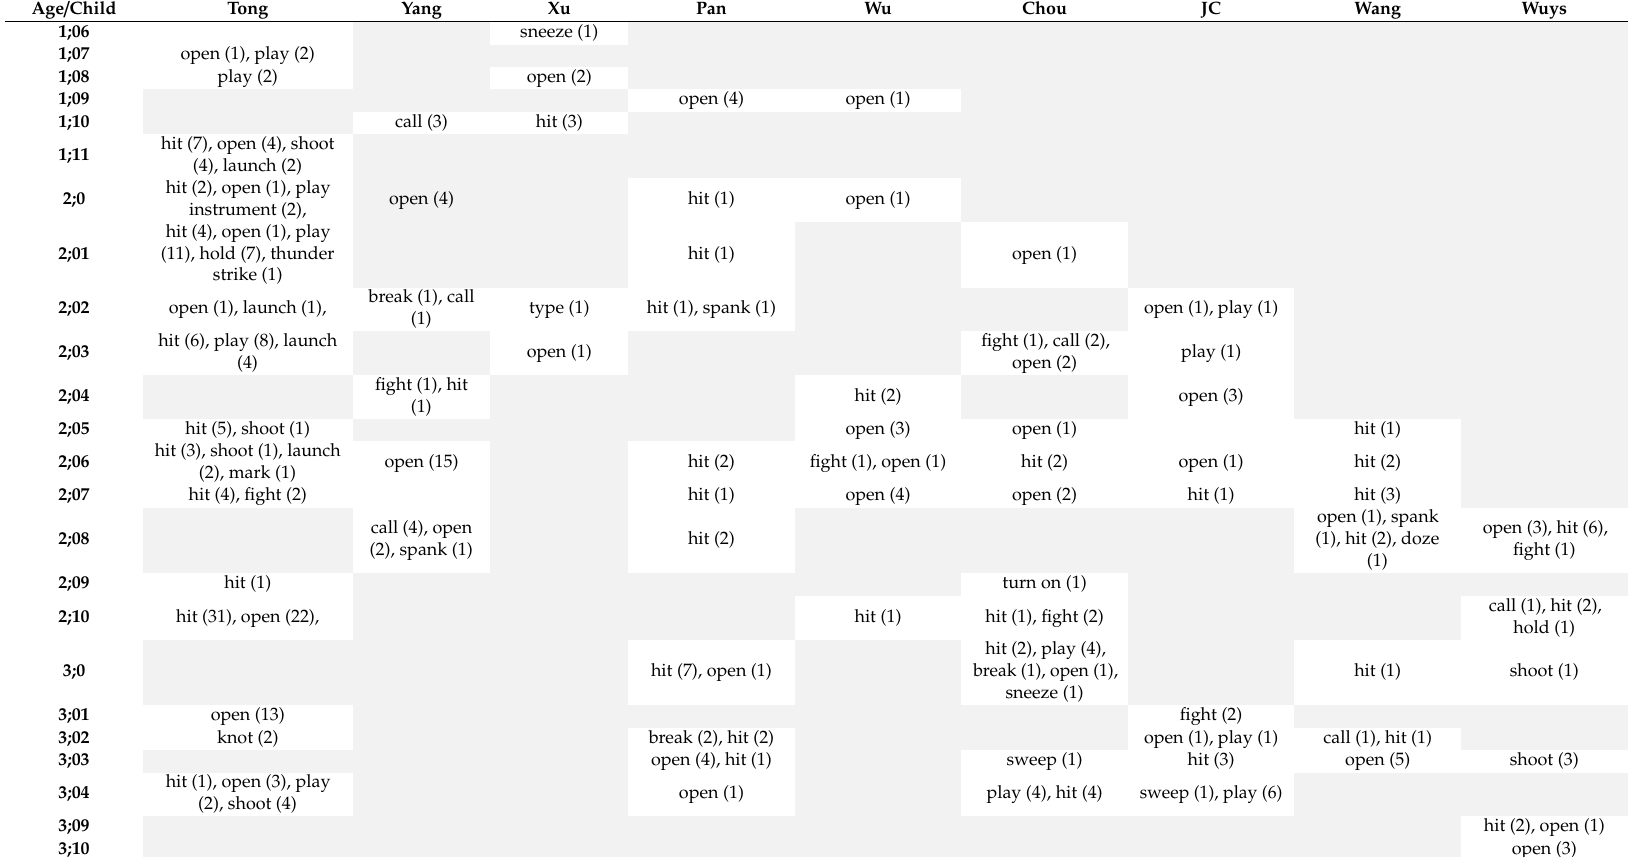
Table 5. Longitudinal emergence of di ff erent senses of 打 dˇa in all children’s speech, (numbers in parentheses indicates token frequency; play = play games ; grey areas indicate gaps in data collection or no production of 打 dˇa